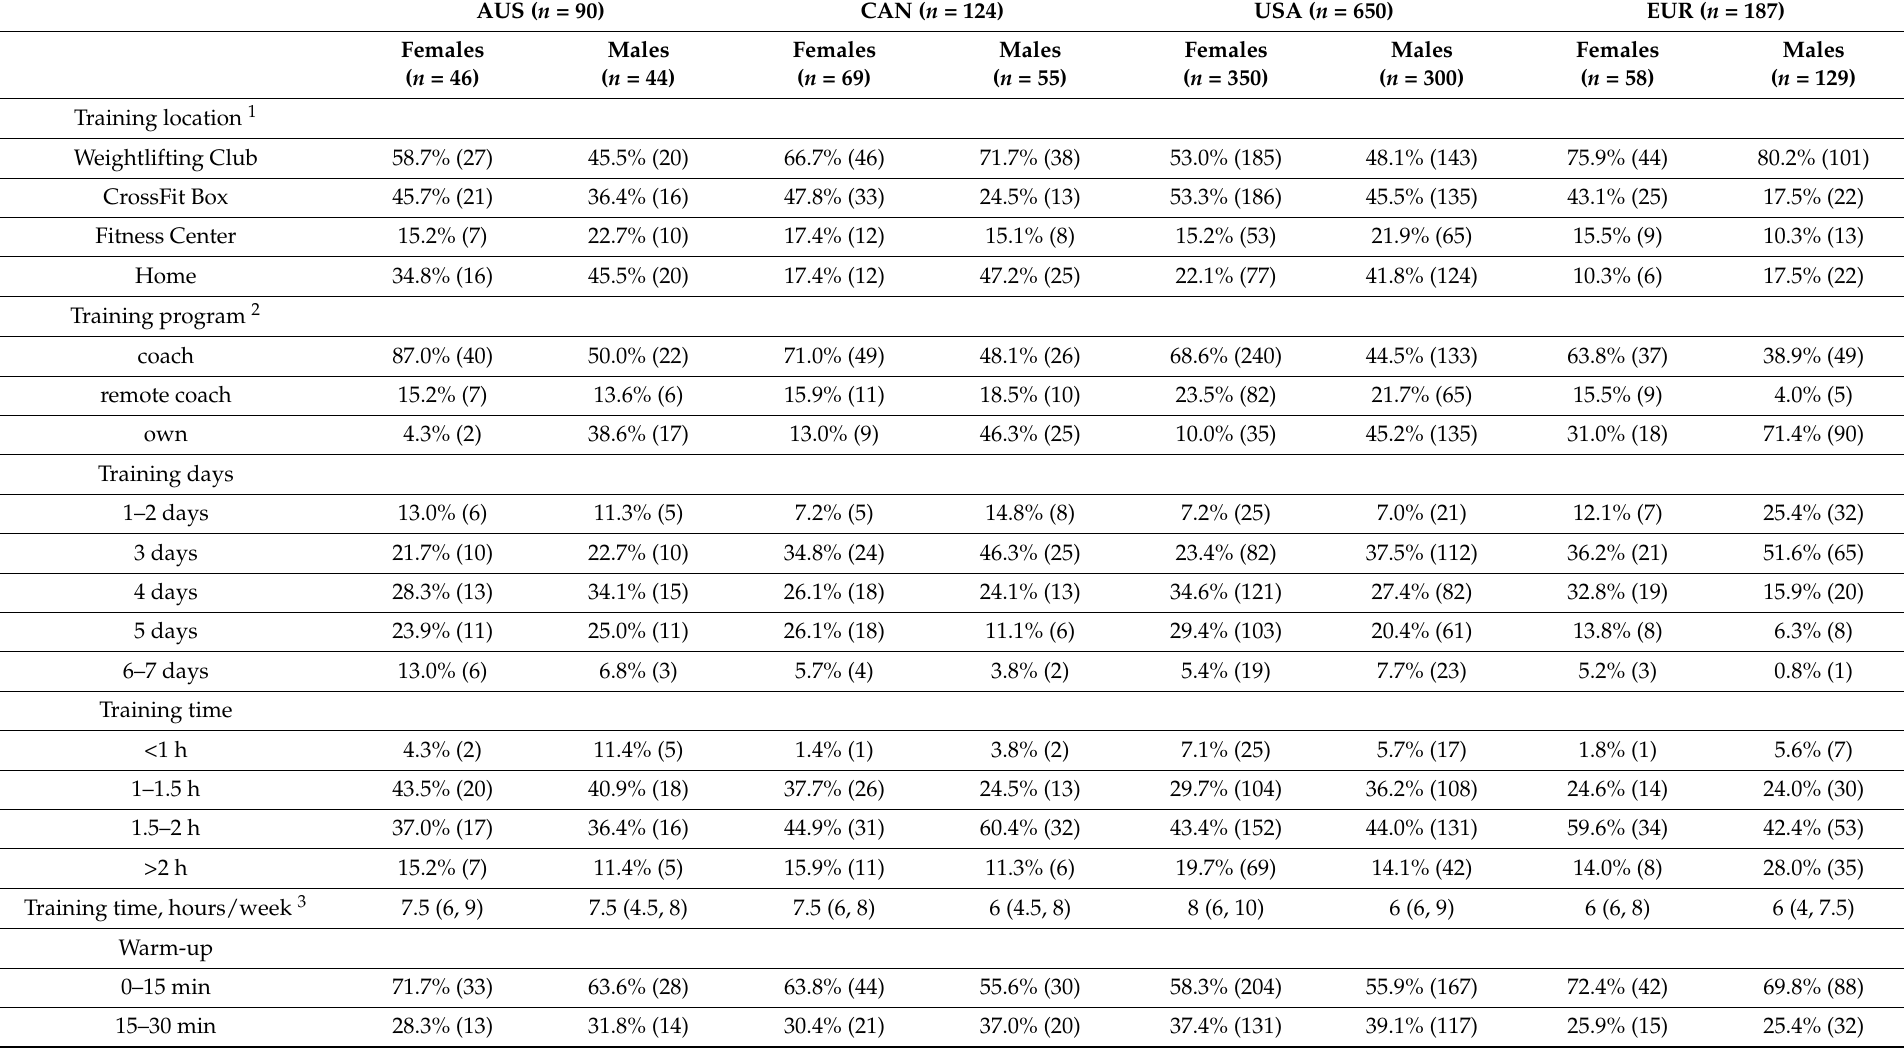
Table 3. Training variables by